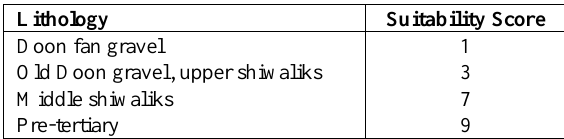
Table 6. Suitability Scores given for different Lithology